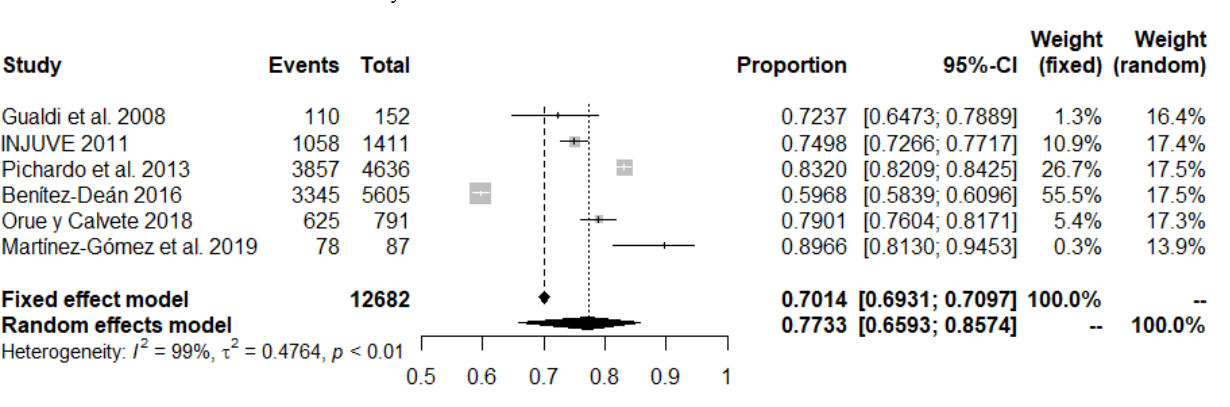
Figure 2. Forest plot of bullying observation studies.